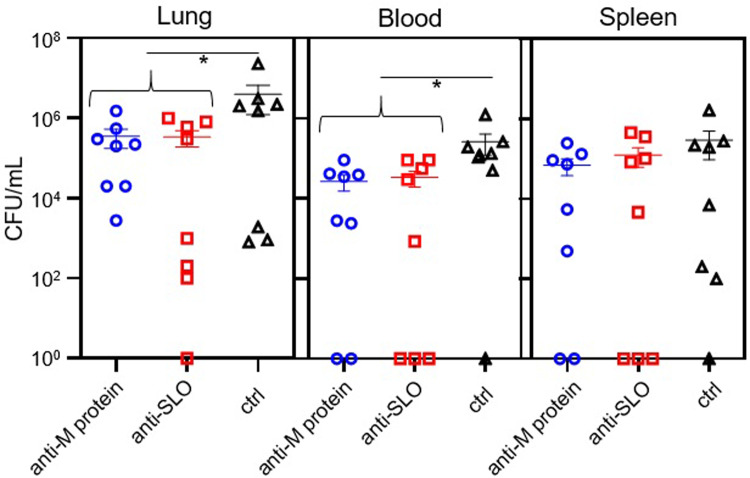
Quantification of GAS in the lungs, blood, and spleens of mice treated prophylactically with antisera.Mice were infected i.n. with 0.1 LD50 IAV on day 0. On day 7, mice were treated with antisera specific to either the M protein or SLO, or non-immune sera (ctrl) and superinfected 6 h later with GAS (0.1 LD50). Mice were euthanized 24 h later and the number of GAS present in blood, lungs, and spleens was determined by dilution plating. Differences between the individual groups were not statistically significant (p > 0.05); however, the difference in the number of bacteria in the lungs and blood of mice treated with either antisera to SLO or the M protein was lower compared to those treated with non-immune sera (p < 0.05; *). Statistical significance was determined with the Student's t-test.